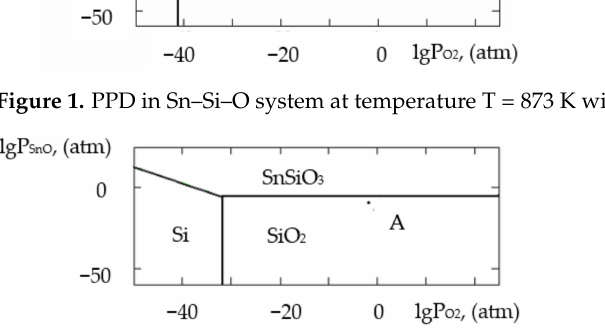
Figure 2. PPD in Sn–Si–O system at temperature T = 1073 K within lgP O2 –lgP SnO coordinates.